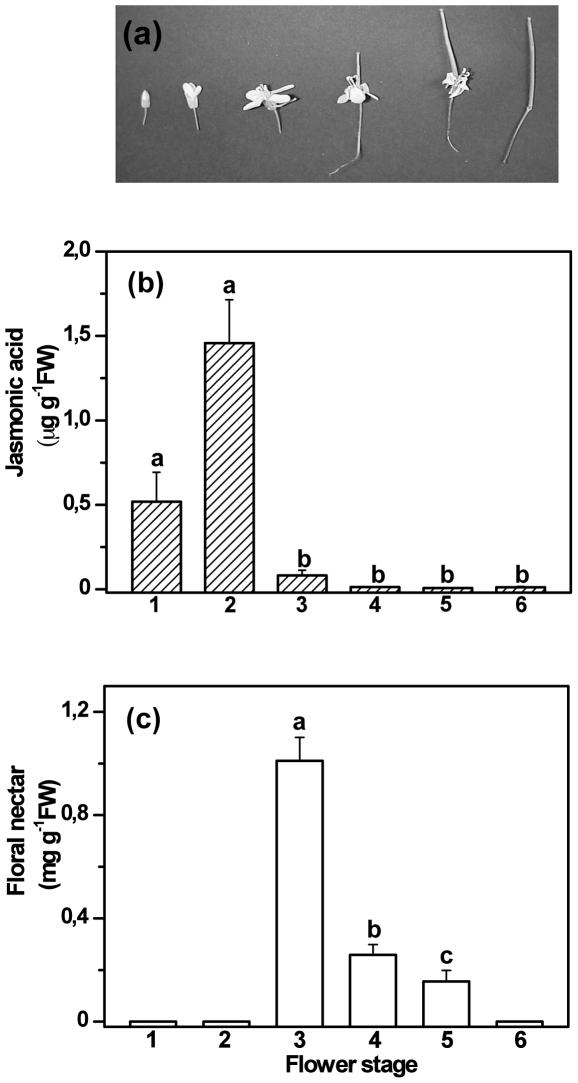
Ontogenetic changes of nectar secretion and endogenous JA in flower tissue.Panel A: Flower stages 1–6 as defined for the present study. Panel B: JA concentration (mean ± SE) is displayed in ng JA per g fresh mass. Different letters indicate significant differences among different stages (LSD post-hoc test after univariate ANOVA, P<0.02, n = 5). Panel C: Nectar secretion (mean ± SE) is given in mg soluble solids per g fresh mass of the flowers. Different letters indicate significant differences among stages (LSD post-hoc test after univariate ANOVA, P<0.01, n = 10). Only the flower stages with nectar secretion (3–5) were included in the post-hoc test in order to avoid inhomogeneity of variances due to zero-production in stages 1, 2 and 6.